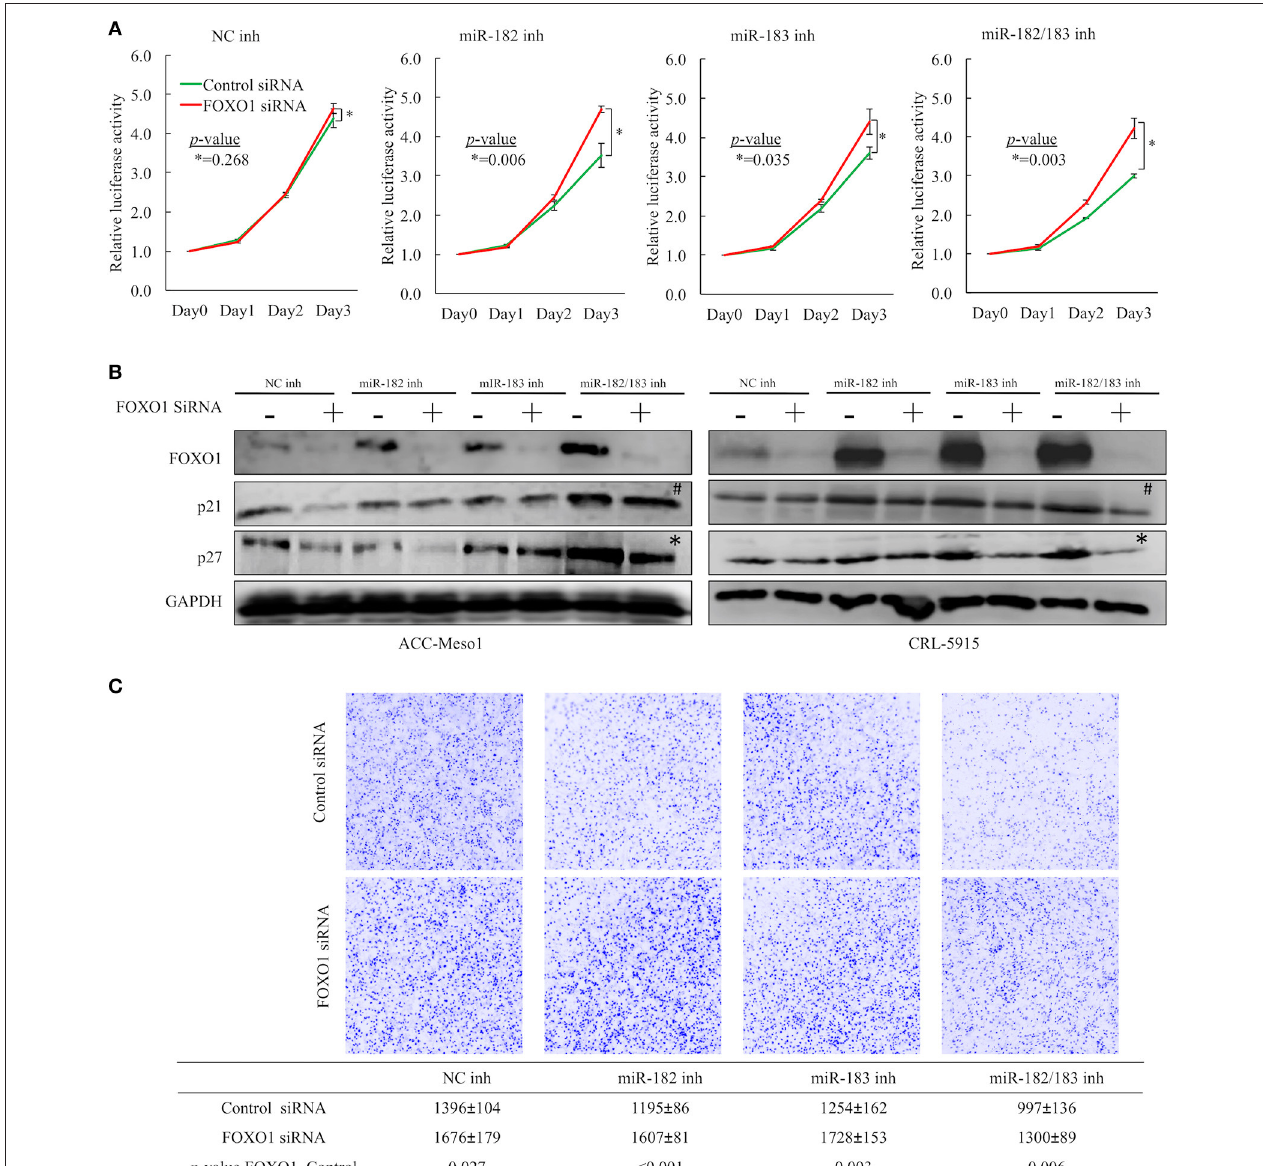
FIGURE 4 | (A) Results of cell proliferation assay showing that transfection with FOXO1 siRNA counteracted the growth-suppression effects of miR-182 and miR-183 inhibitors when cells were co-transfected with microRNA inhibitors and FOXO1 siRNA. (B) Western blot showing FOXO1 siRNA countered the upregulated expression of FOXO1 by miRNA inhibitors. Moreover, FOXO1 siRNA also downregulated p27 expression in cells treated with both miR-182 and miR-183 inhibitors (*), but not clear with p21 expression (#). (C) Results of invasion assay demonstrating that transfection with FOXO1 siRNA counteracted the cell invasion-promoting effects of miR-182 and miR-183 inhibitors when cells were co-transfected with microRNA inhibitors and FOXO1